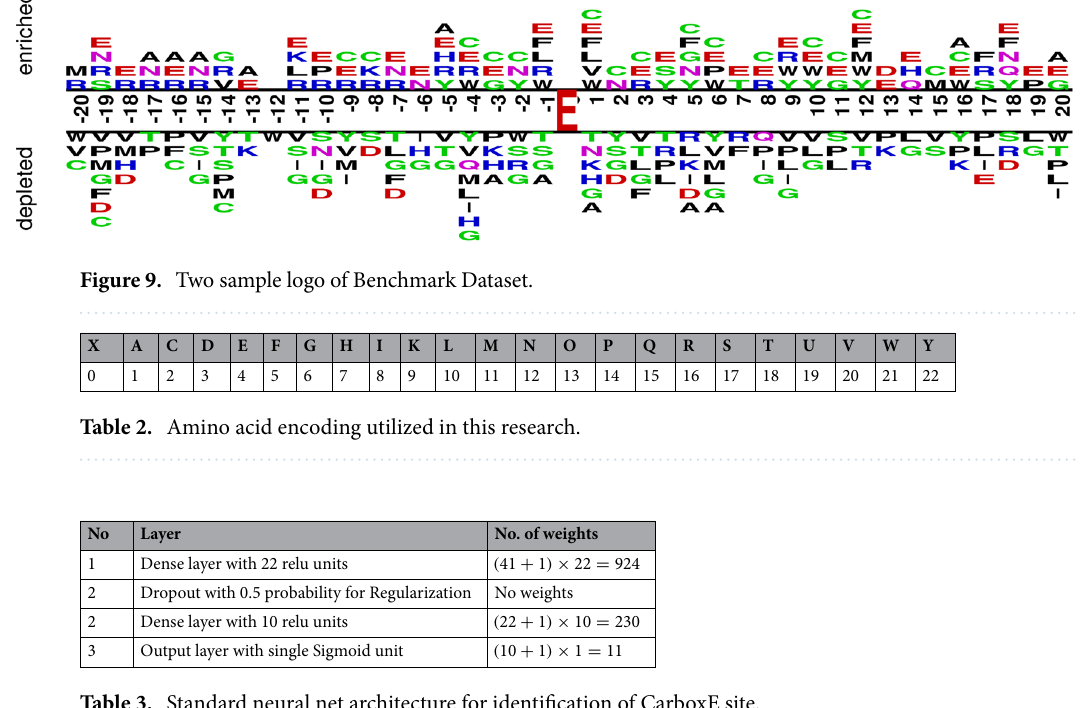
Table 3. Standard neural net architecture for identification of CarboxE